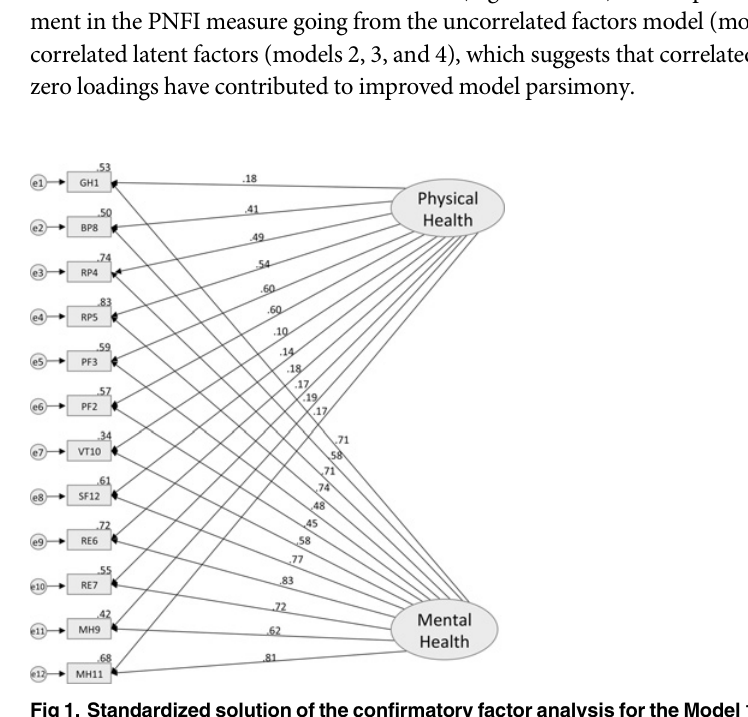
Fig 1. Standardized solution of the confirmatory factor analysis for the Model 1. GH1 — General Health: rating of general health; PF2 — Physical Functioning: moderate activities; PF3 — Physical Functioning: climbing several flights of stairs; RP4 — Role Functioning (Physical): accomplished less; RP5 — Role Functioning (Physical): limited in the kind work or other activities; RE6 — Role Functioning (Emotional): accomplished less (emotional problems); RE7 — Role Functioning (Emotional): less carefully than usual; BP8 — Bodily Pain: pain interference; MH9 — Mental Health: calm and peaceful; VT10 — Vitality: energy; MH11 — Mental Health: downhearted and depressed; SF12 — Social Functioning: health/emotional problems interfered with